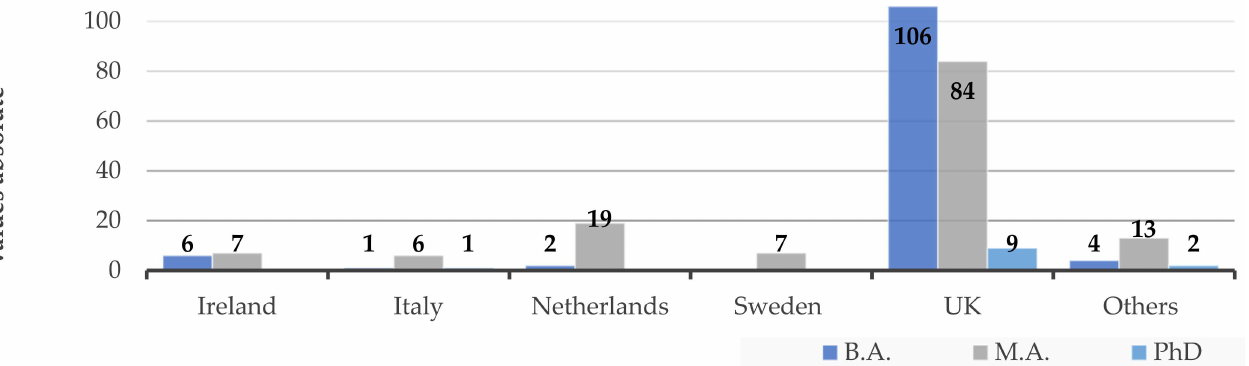
Figure 19). In European countries, Bachelor’s programs are minimal or unavailable (e.g., Sweden or The Netherlands).